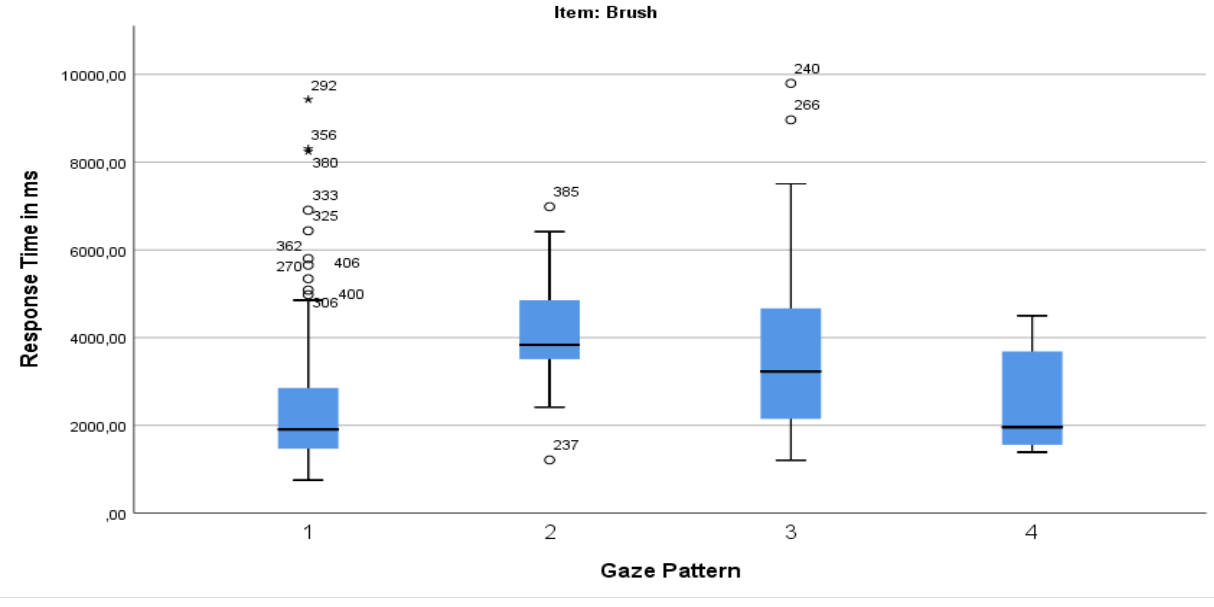
Figure 9: Boxplot for Gaze Pattern and Response Time (in ms) for the item brush. Response time and angle for wrench and brush.